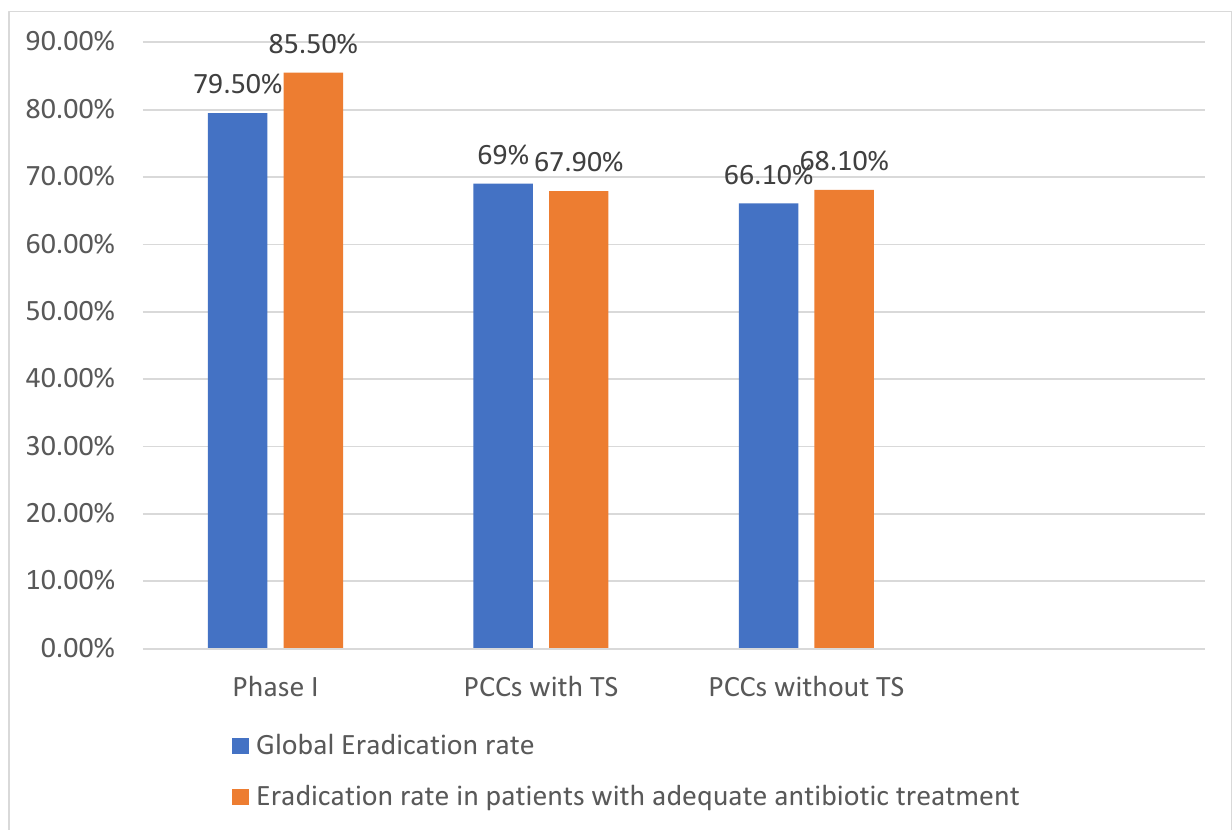
Figure 2. Eradication rates. PCCs: primary care centres; TS: training sessions.